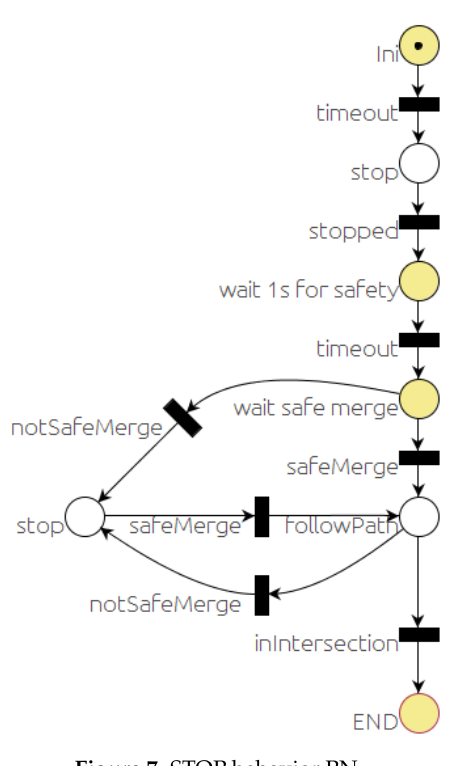
Figure 7. STOP behavior